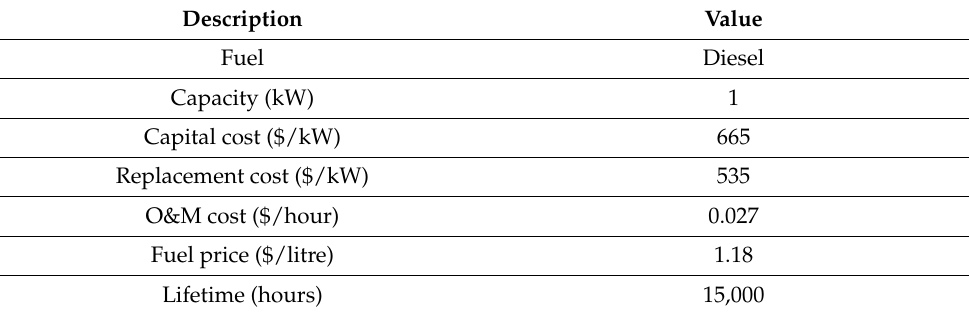
Table 5. Technical specifications of diesel